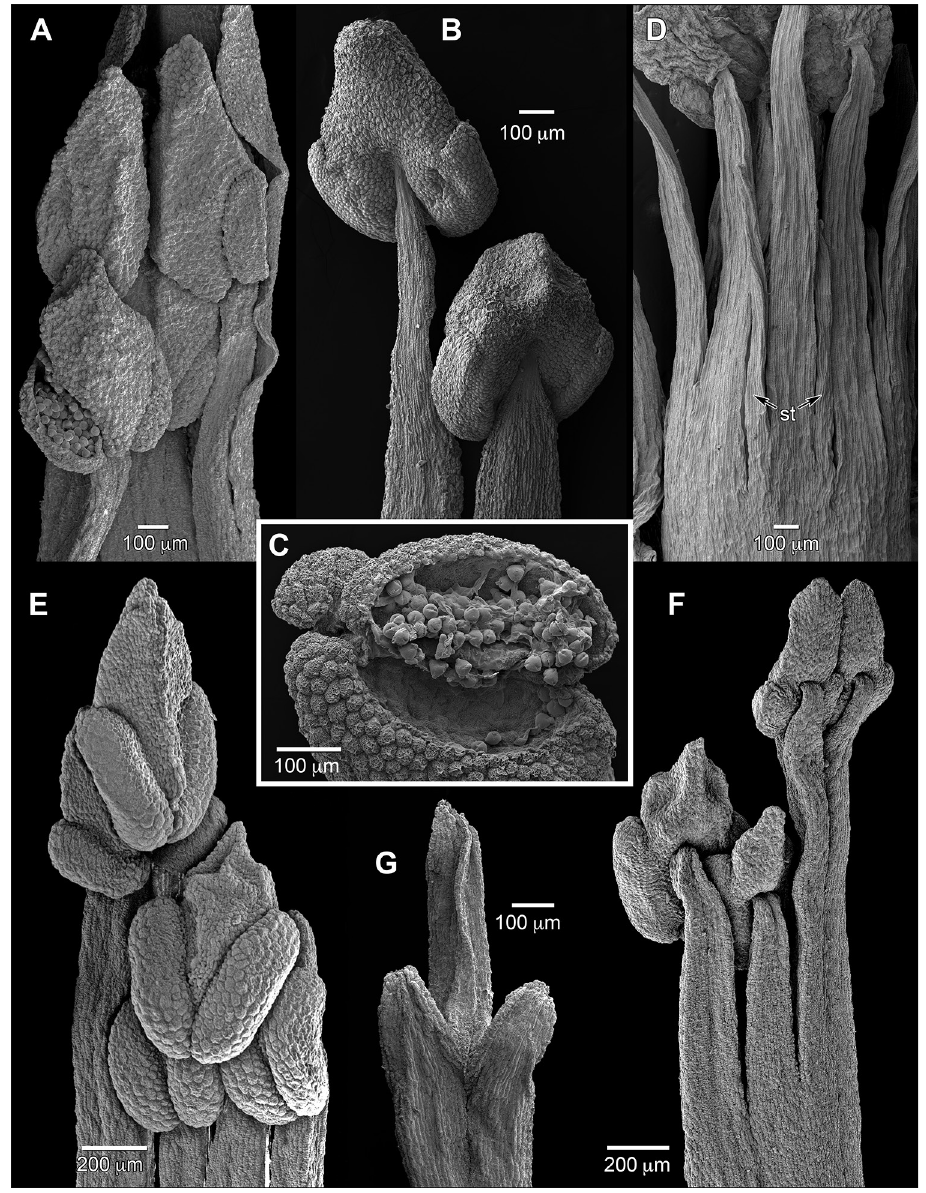
Figure 2 . Stamen structure of Humiriaceae. A Sacoglottis perryi stamen cluster of 2 types, ventral B Saco- glottis perryi stamen cluster of 2 types, dorsal C Sacoglottis perryi short-stamen anther with open stomium and pollen D Sacoglottis guianensis androecium with interstaminal staminodes (st), dorsal E Schistostemon macrophyllus stamen cluster of 3 types, ventral F Schistostemon macrophyllus stamen cluster of 3 types, dorsal G Schistostemon oblongifolius trifurcate filament tip, dorsal. Sources: A–C Tripp 2984 D Carvalho et al. 4396 E, F Maas et al. 6577 G Maas et al. 6804 (all